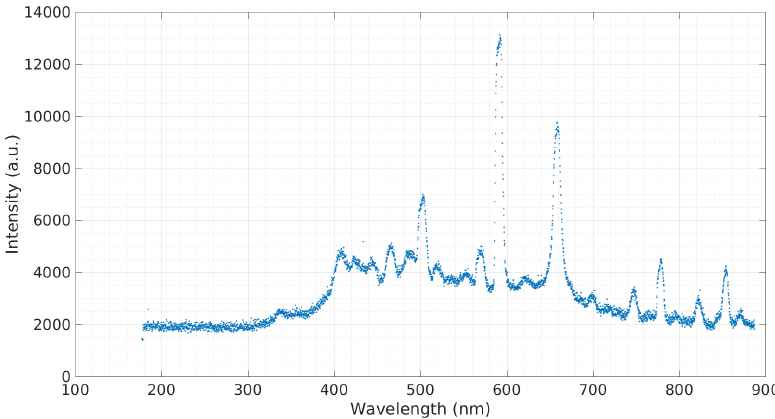
Figure 7. Cesium in saltwater.